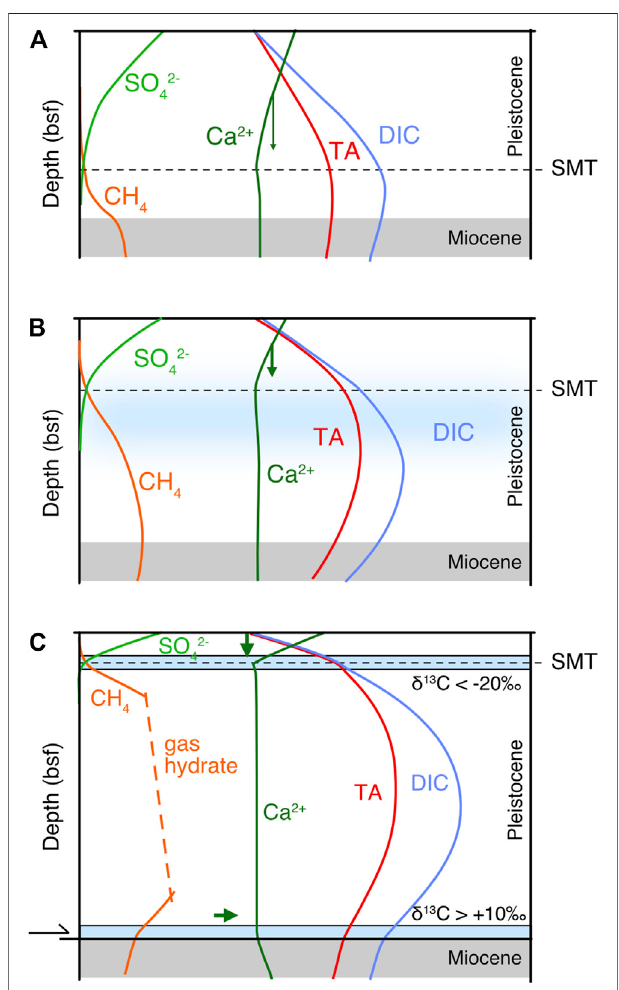
FIGURE 7 | Conceptual model to explain the formation of diagenetic carbonates in relation to the evolution of the methanogenic zone: (A) During Pleistocene sedimentation over the Miocene, dissimilatory reactions lead to the onset of a methanogenic zone. (B) Within the expanding methanogenic zone alkalinity builds up, but insigni fi cant carbonates (disseminated calcite or dolomite; blue shaded area) are precipitated as the diffusiondistanceforCa 2+ andMg 2+ aretoolong. (C) Themethanogeniczone has now further expanded and a gas hydrate zone has established. The gradients near the surface are steep, with a shallow SMT driving carbonate precipitation (lithi fi ed dolomites; blue bars). Also at depth, fl uid fl ow along the décollement provides Ca 2+ , inducing carbonate precipitation. The two types of dolomite show contrasting δ 13 C values, derived from dissimilatory sulphate reduction and methanogenesis, respectively.